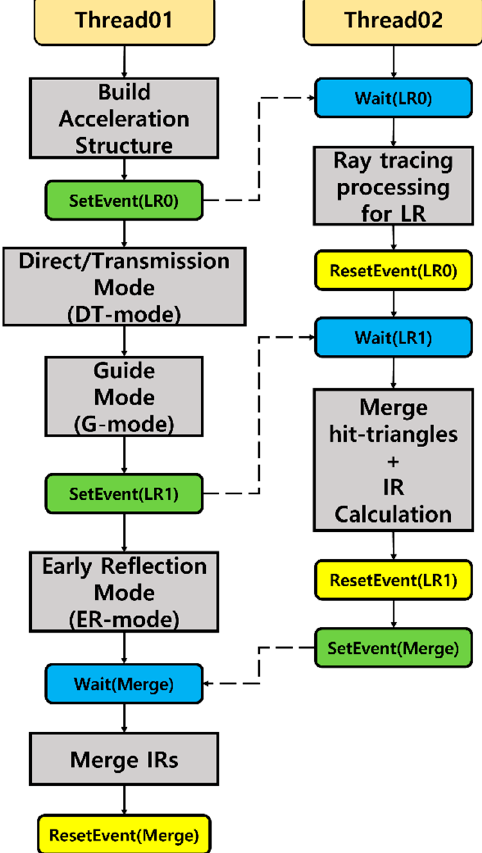
Figure 10. Thread synchronization: Thread01 and thread02 perform synchronization through SetEvent, ResetEvent, and Wait functions.